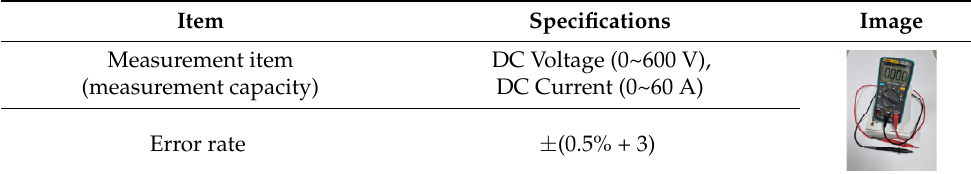
Table 6. Specifications of the voltage and current measuring device (Equipment name: MULLER 3201).